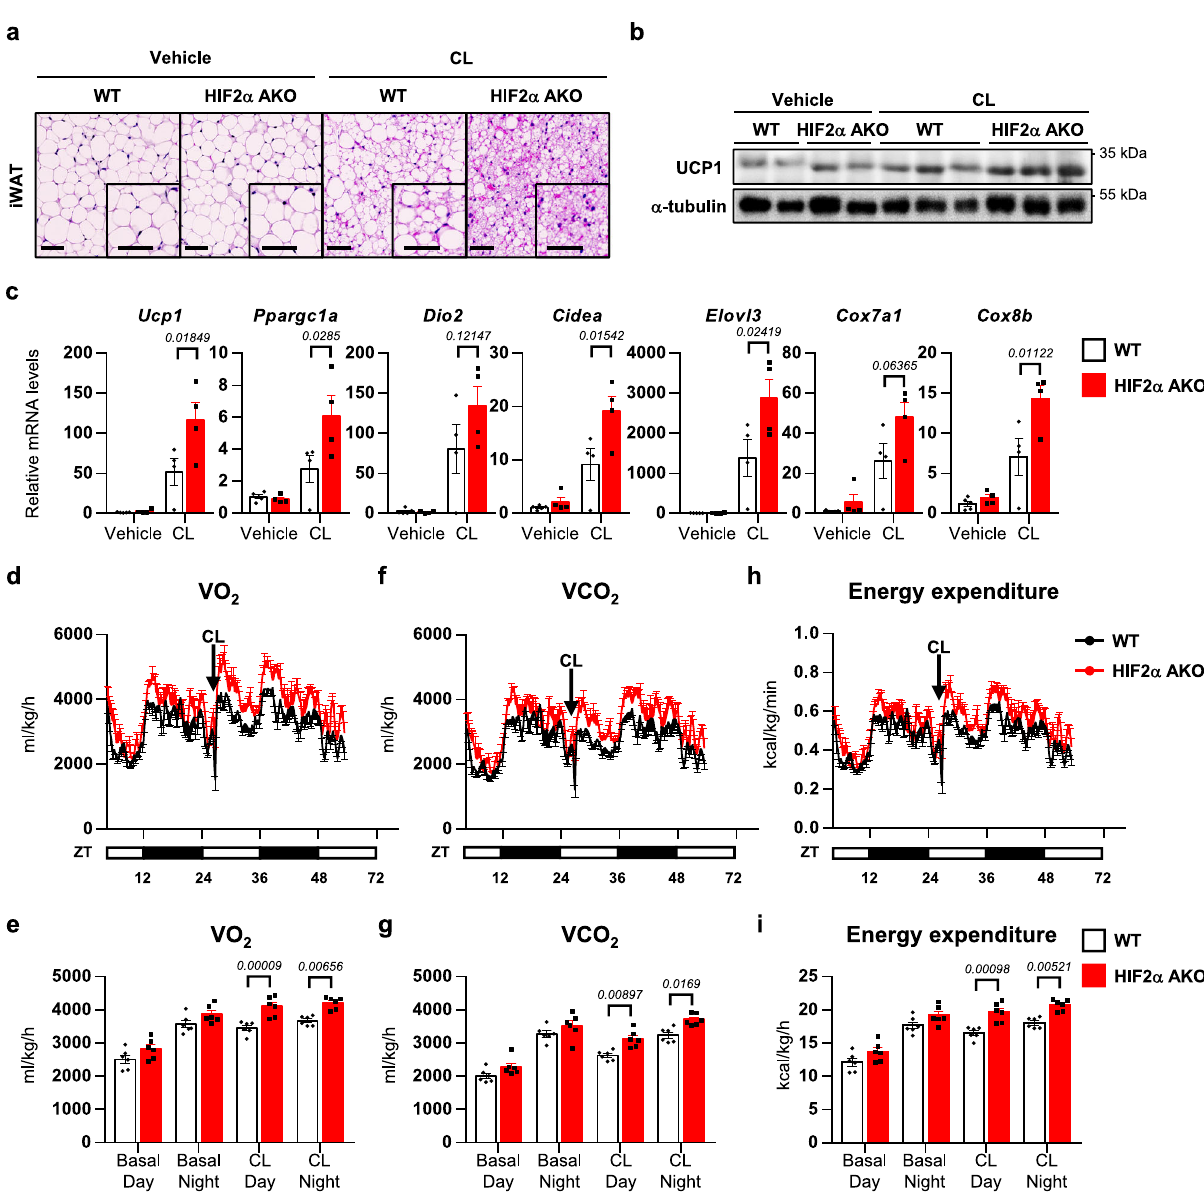
Fig. 3 HIF2 α ablation in adipocytes potentiates energy expenditure upon β 3-adrenergic activation. a Representative images of H&E staining of iWAT from WT and HIF2 α AKO mice upon daily CL administration (0.5 mg/kg, 4 days). Scale bars, 50 μ m. b Western blot analysis of UCP1 in iWAT from WT and HIF2 α AKO mice upon daily CL administration (0.5 mg/kg, 4 days). c mRNA levels in iWAT from WT (Vehicle; n = 5, CL; n = 4) and HIF2 α AKO ( n = 4) mice upon daily CL administration (0.5 mg/kg, 4 days). d – i d , e VO 2 , f , g VCO 2 , and h , i energy expenditure for WT and HIF2 α AKO mice ( n =